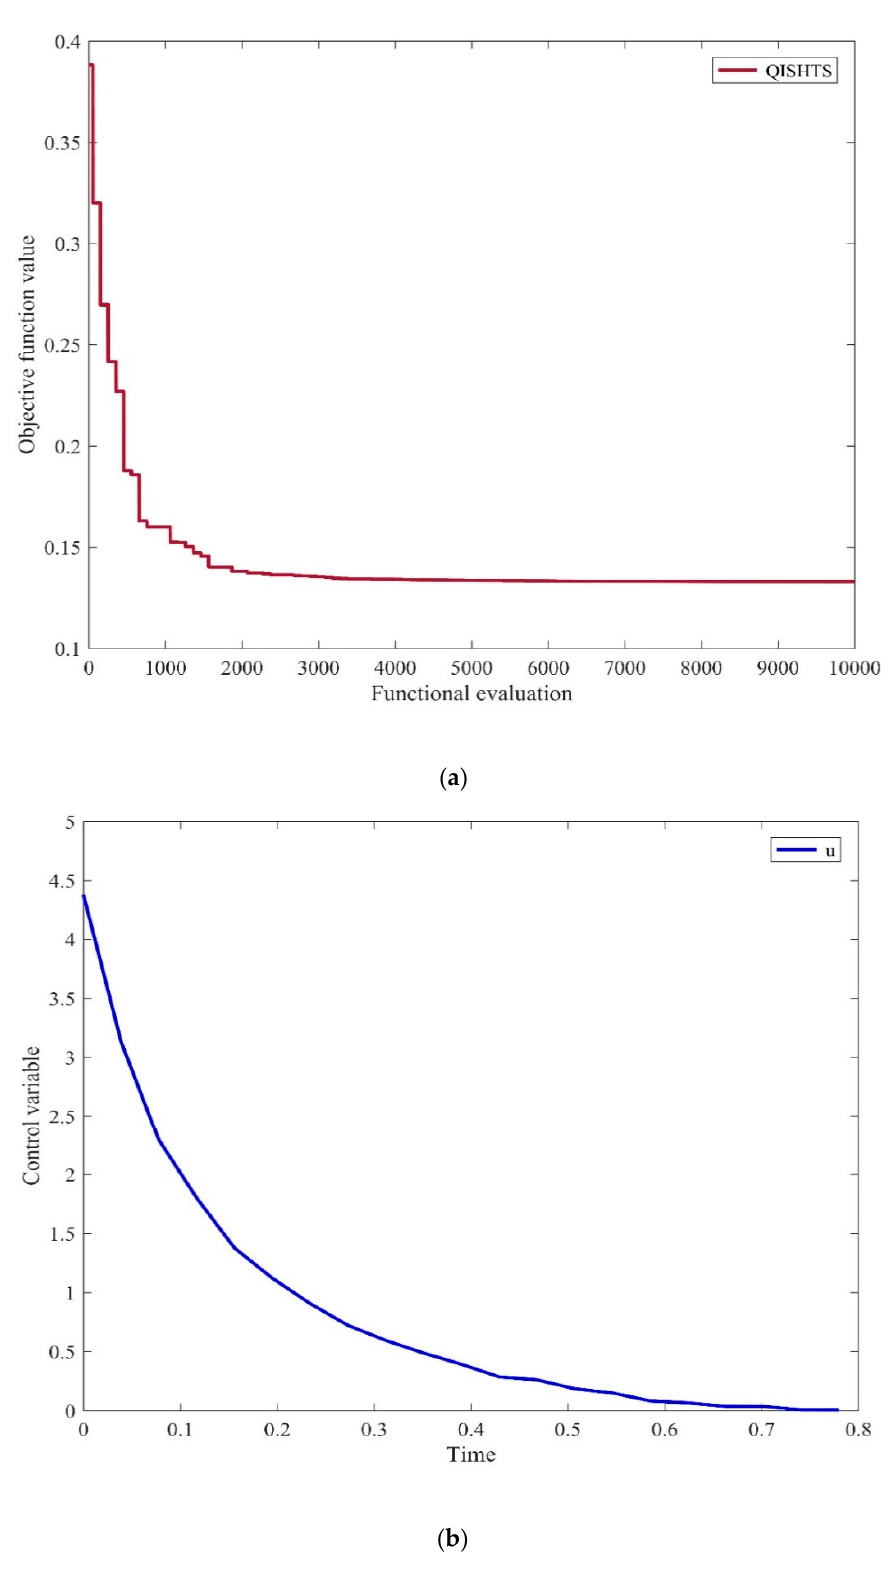
Figure 5. ( a ) Convergence graph of the QISHTS algorithm for the multi-modal CSTR model. ( b ) Optimal control trajectory for the multi-modal CSTR model. u portrays the optimal control variable of this problem.